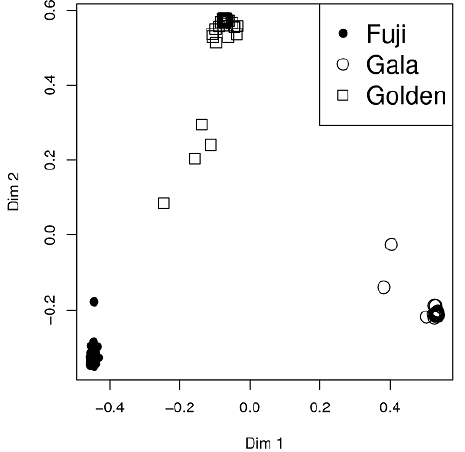
Figure 5. Headspace VOC analysis of apple clones with PTR-ToF-MS. Random Forest graphical output for the discriminant analysis of the PTR-ToF-MS data of apple clone samples. Reprinted with permission from [54]. Copyright 2012 Springer Science+Business Media,